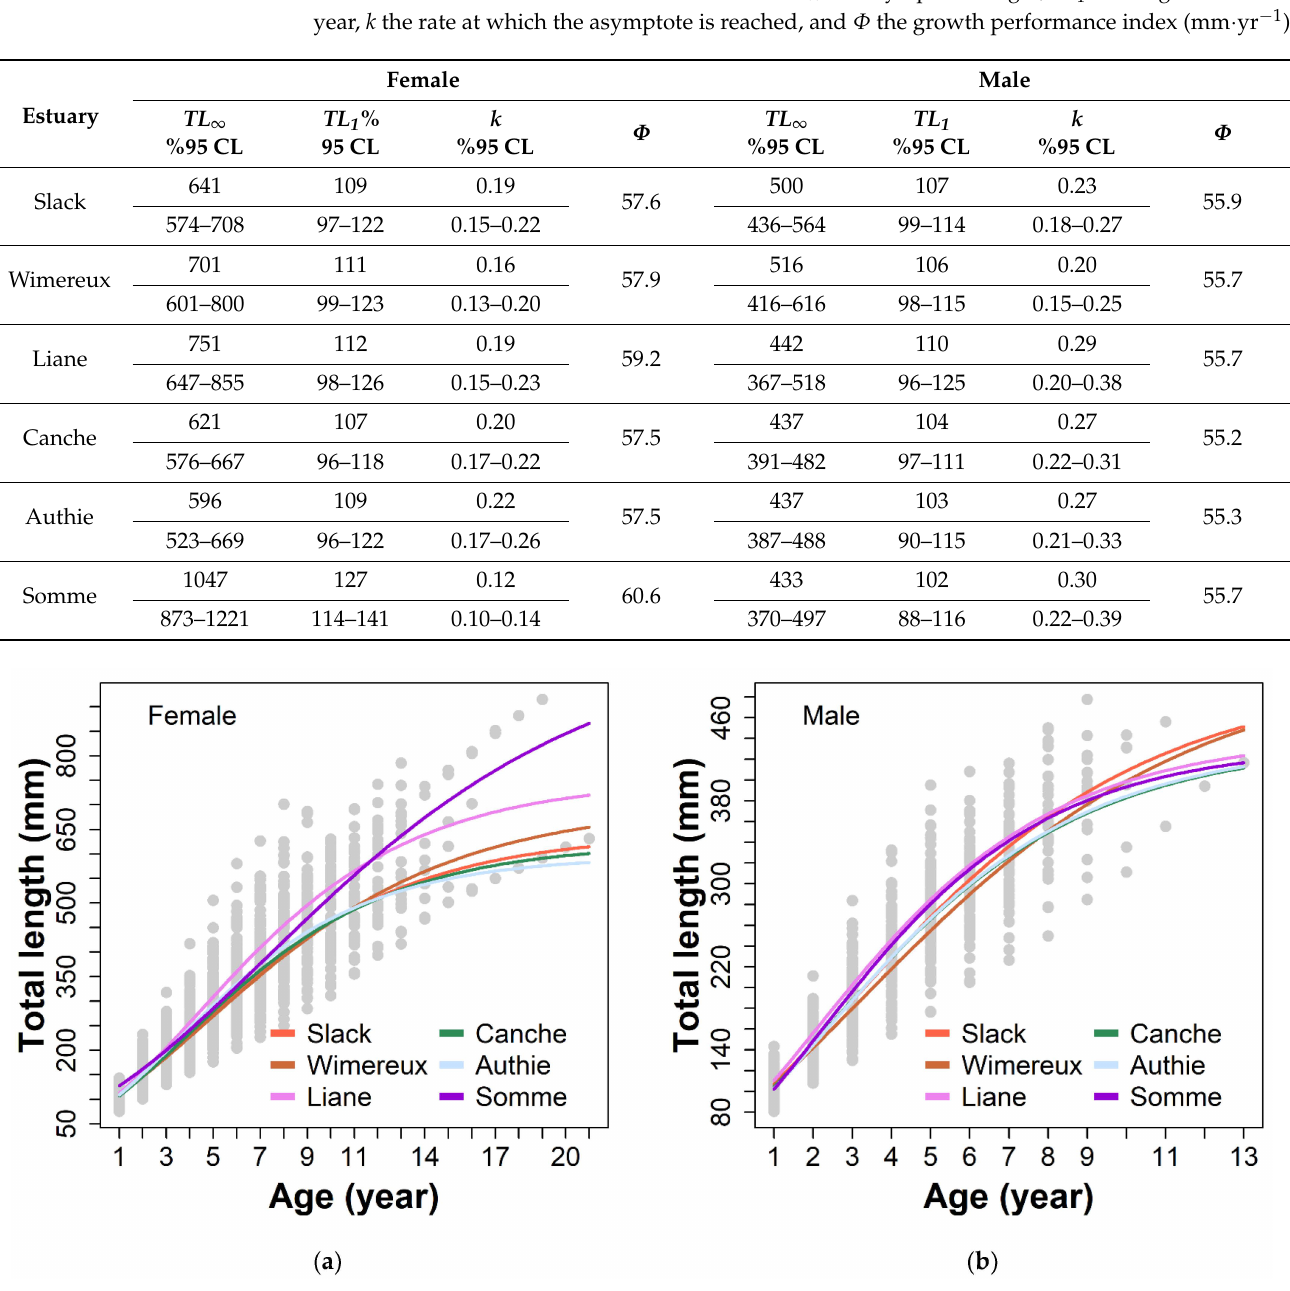
Figure 4. Gompertz growth model (colored lines) fitted to eels’ total length-at-age data collected in the six estuaries for ( a ) female and ( b ) male eels (grey